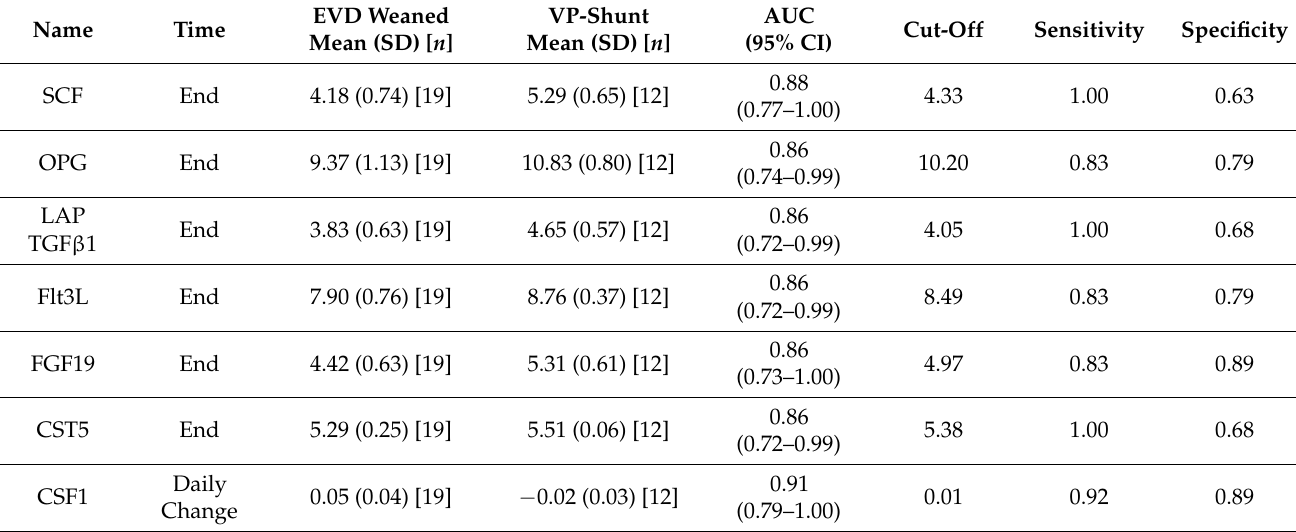
Table 1. Acceptable predictors of hydrocephalus measured by the Olink 96 inflammation panel. Inflammatory markers with AUC values above 0.7. AUC: area under the curve; CI: confidence interval; SD: standard